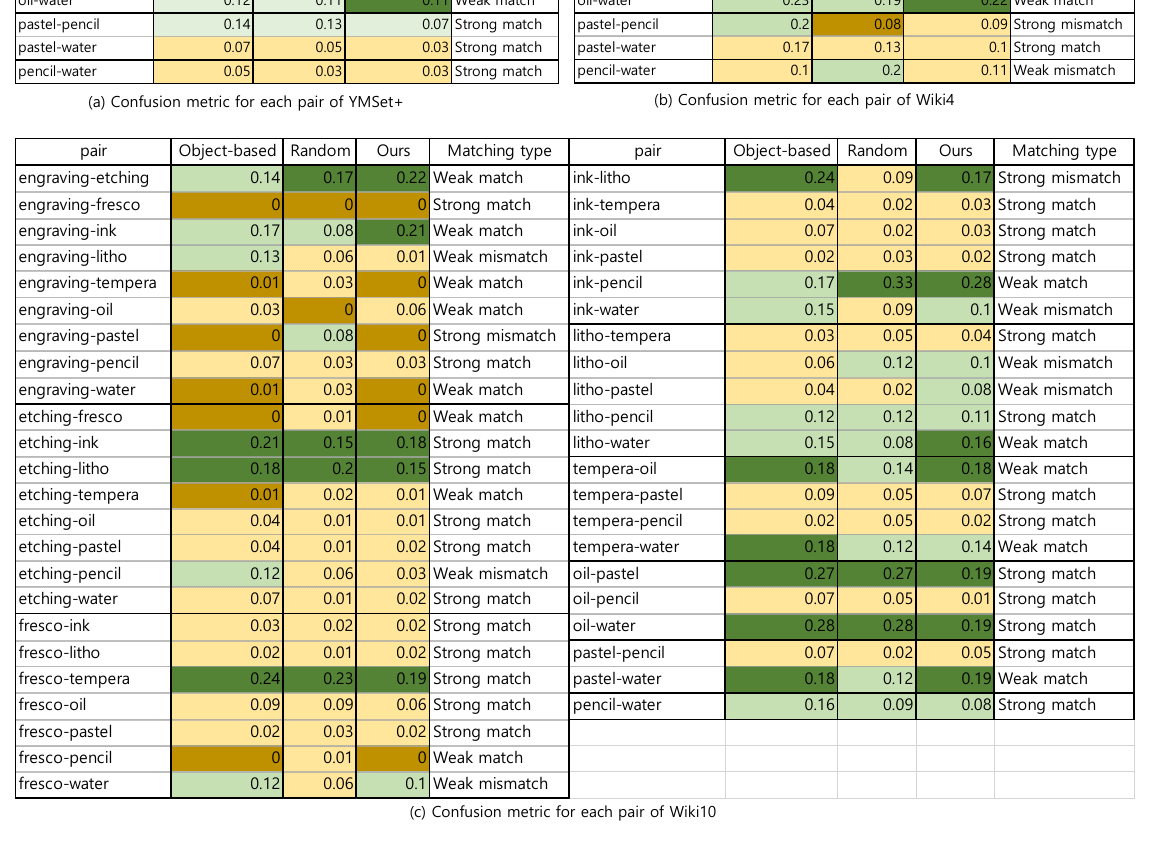
Figure 21. Confusion metrics and their matching types for each media pair from the three datasets and three sampling schemes.